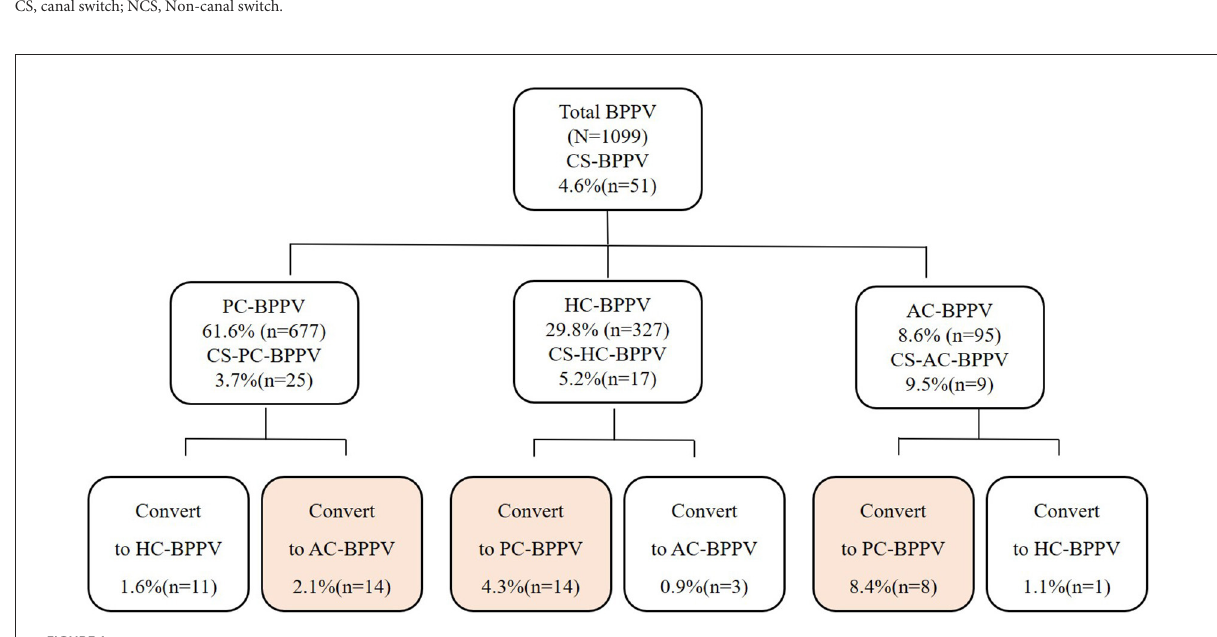
FIGURE1 The distribution of canal switch in BPPV. BPPV, benign paroxysmal positional vertigo; CS, canal switch; PC, posterior canal; HC, horizontal canal; AC, anterior